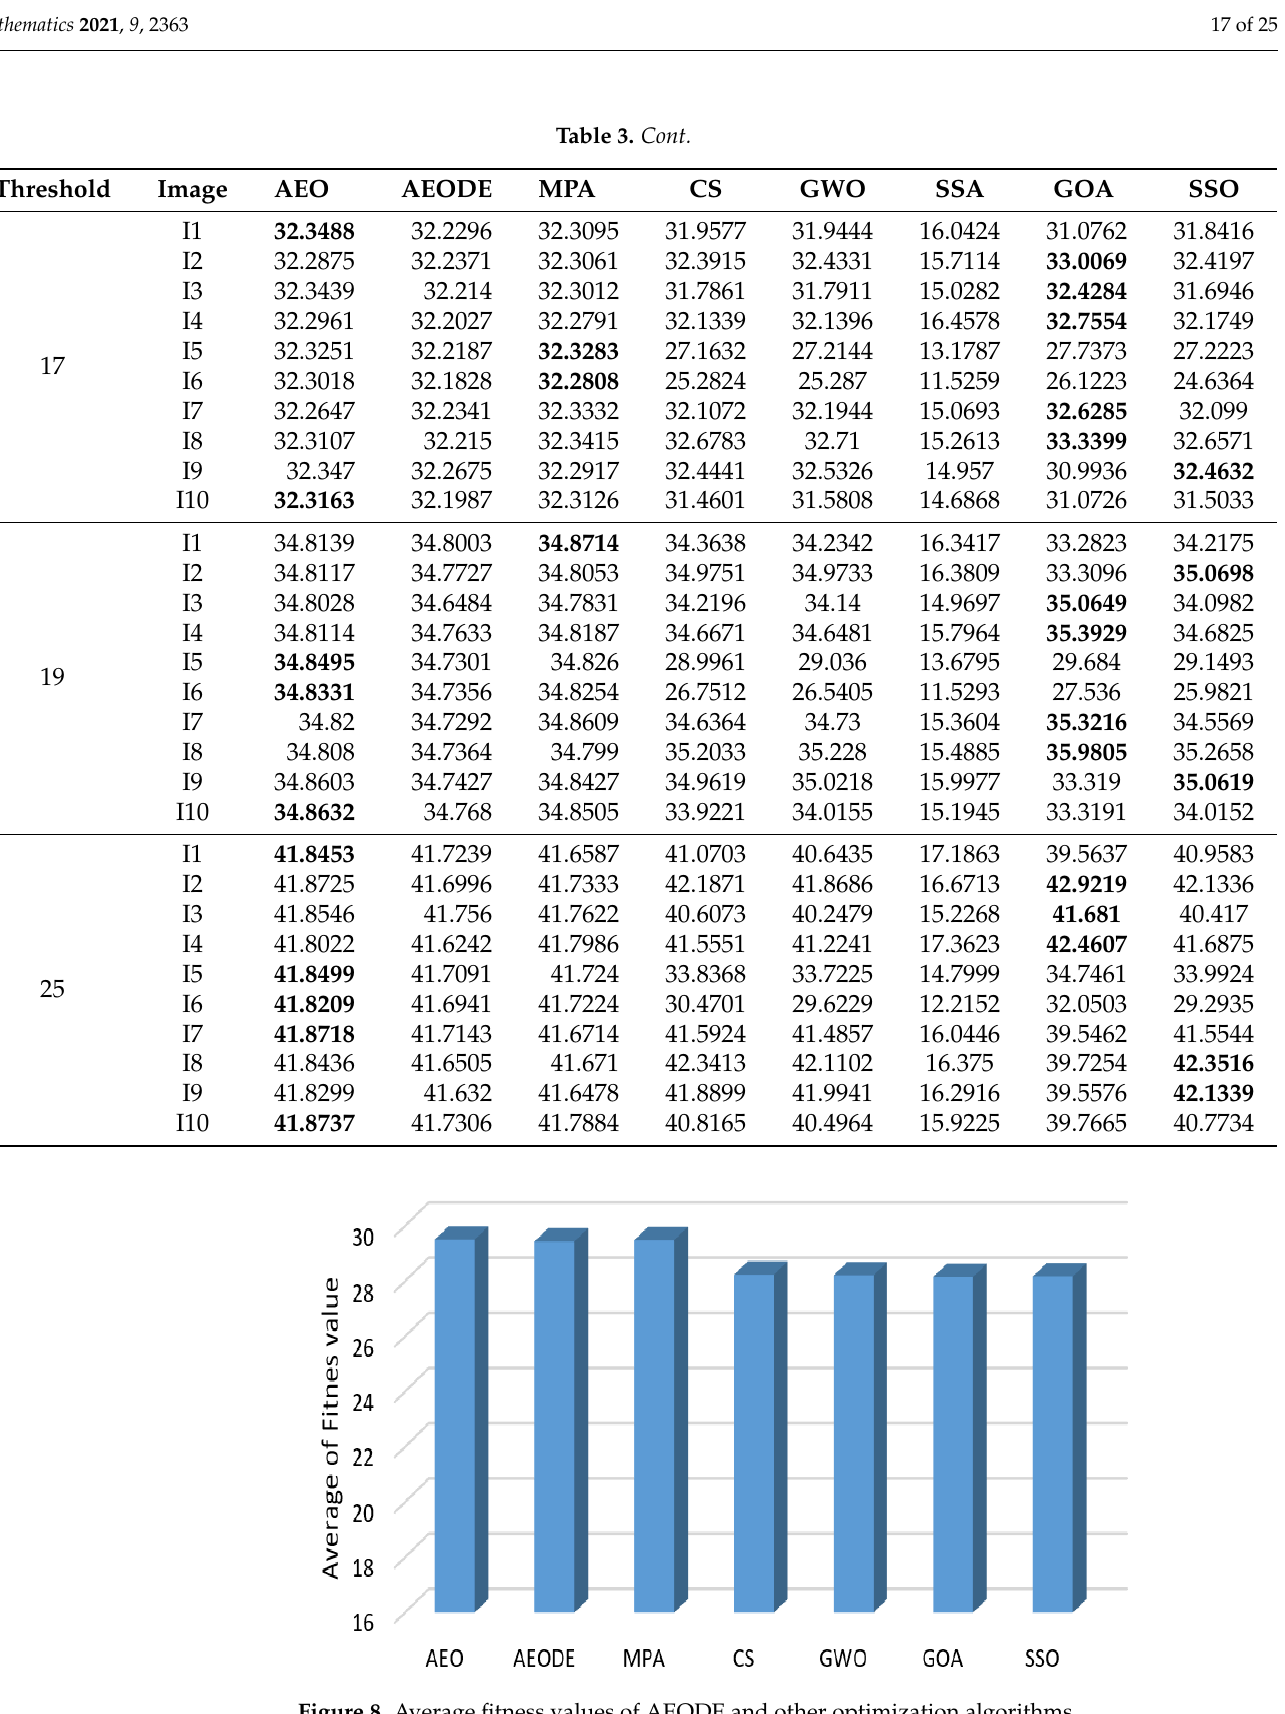
Figure 8. Average fitness values of AEODE and other optimization